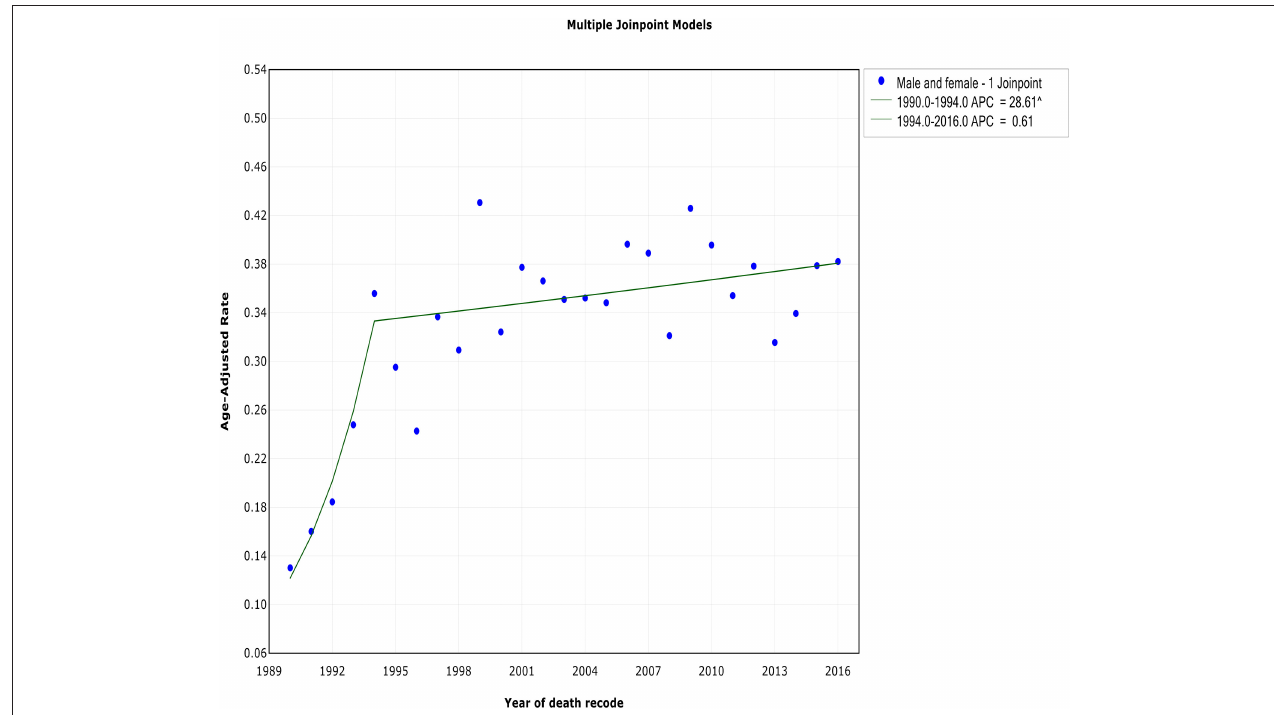
FIGURE 2 | The overall trends in the incidence-based mortality of Waldenström